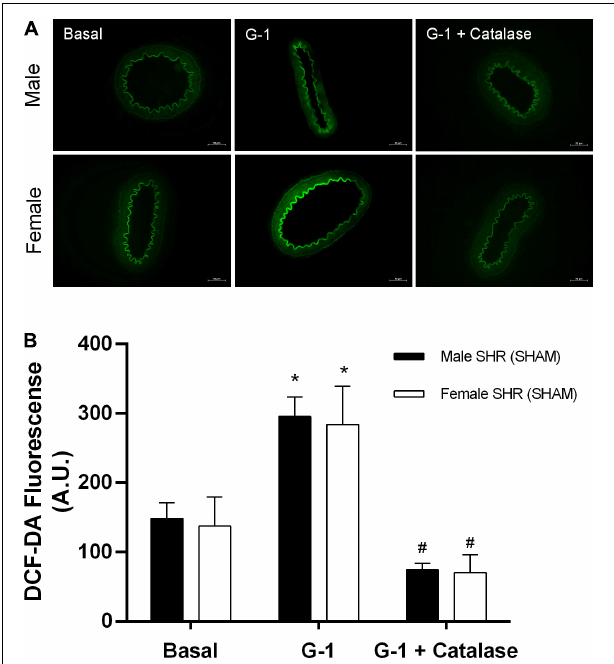
FIGURE 11 | (A) Fluorescence microscopy analysis emitted by DHE in mesenteric resistance arteries from SHR. Protocols were performed in the absence and presence of G-1 (10 µ M) and Tiron (10 µ M), an ROS scavenger. (B) Fluorescence analysis produced in Male ( n = 5) and Female ( n = 6) groups. Scale bar = 50 µ m. Values are expressed as mean ± SEM. # P < 0.05 compared with G-1 stimulation of the same group. Two-way ANOVA was used for the analysis, followed by the Sidak post hoc